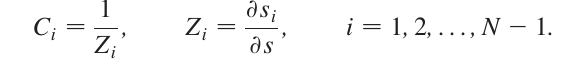
on the compression curve along the bunch. For Z 00 0 2